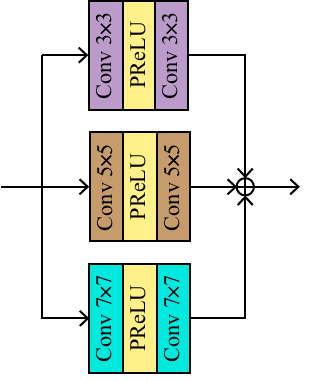
Figure 5. Adaptive multi-scale block